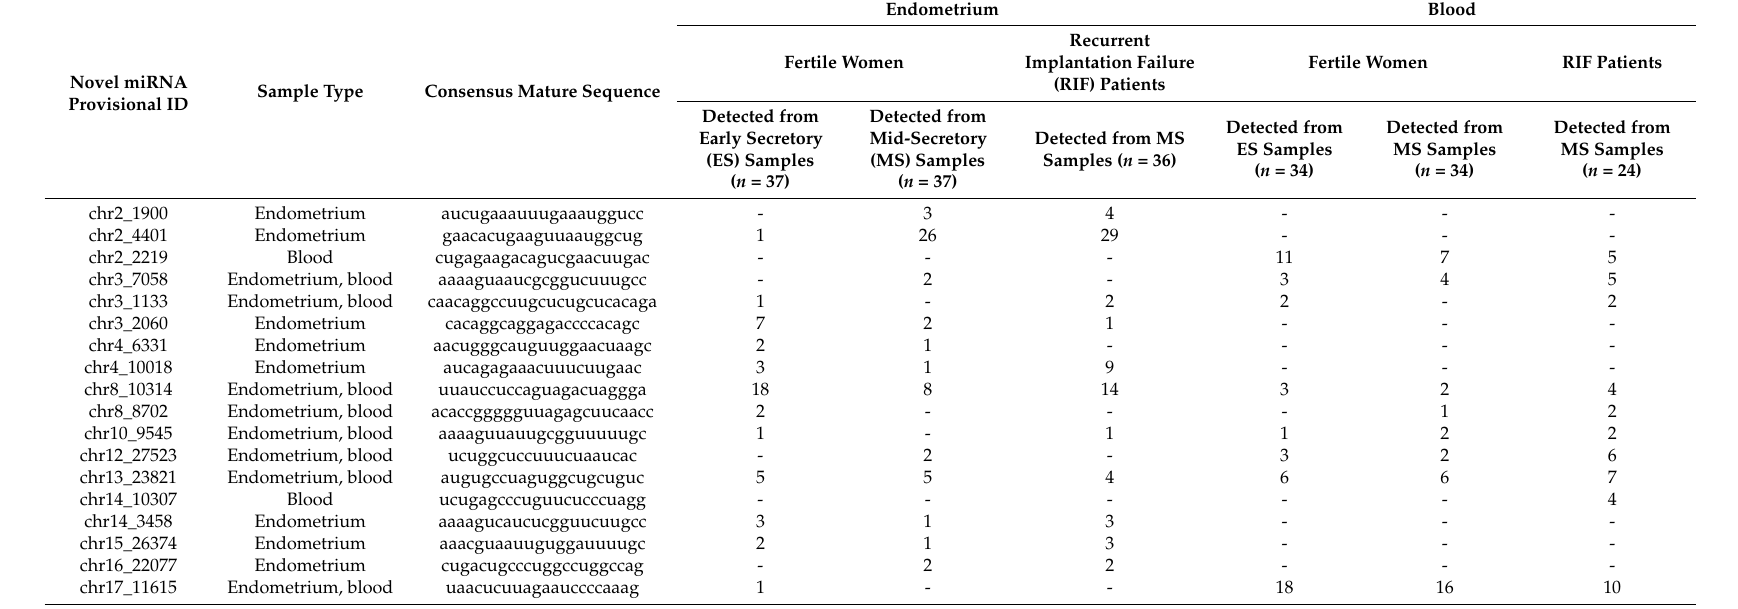
Table 1. Novel miRNAs detected from endometrial and blood